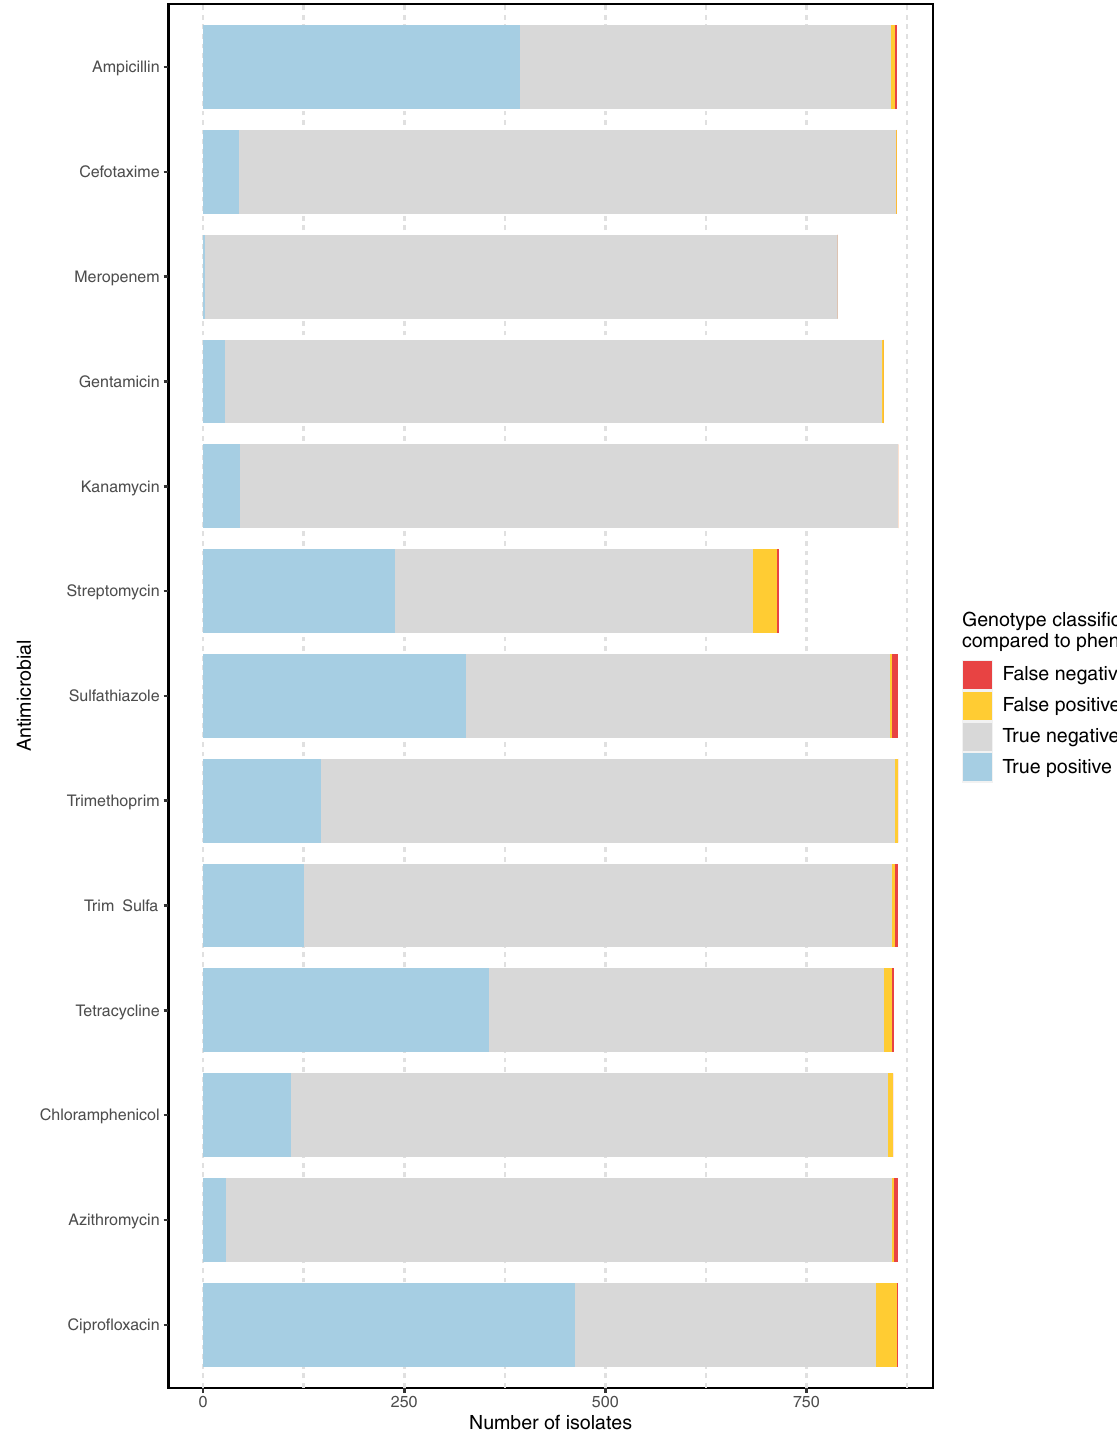
Fig. 6 | Performance of inferred phenotype from abritAMR compared to anti- microbial susceptibility testing (AST). Classi fi cation of genotype (AMR mechanism detection) compared to the ‘ gold standard ’ phenotypic AST for each isolate and antimicrobial. True positive,genotypicand phenotypicresistance; true negative,noAMRmechanismsdetectedinphenotypicallysusceptibleisolate;false positive, AMR mechanism identi fi ed in phenotypically susceptible isolate; false